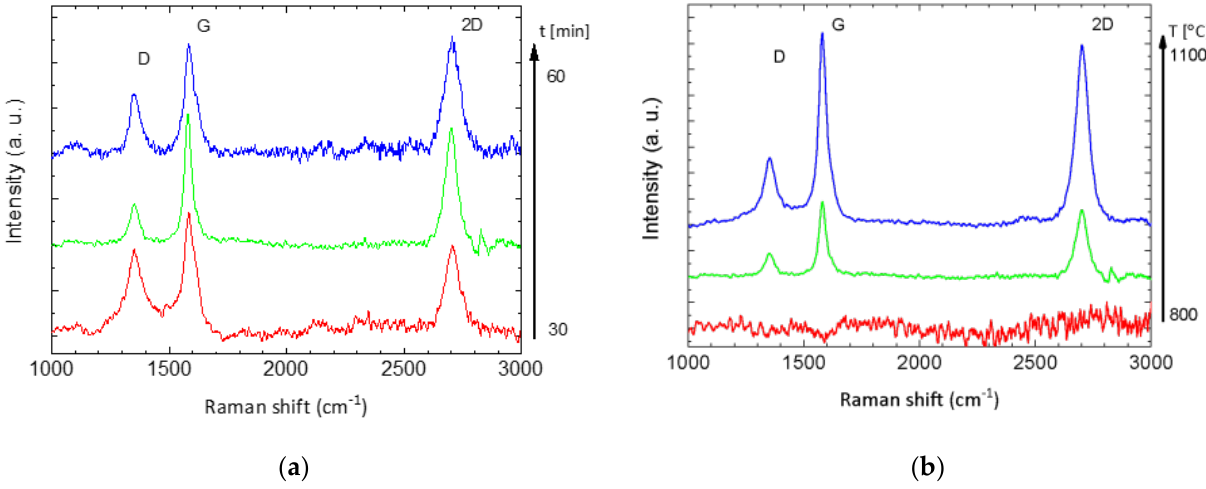
Figure 6. Raman spectra of the Co-Cr alloys as a function of the time deposition ( a ) and the temperature deposition ( b ).